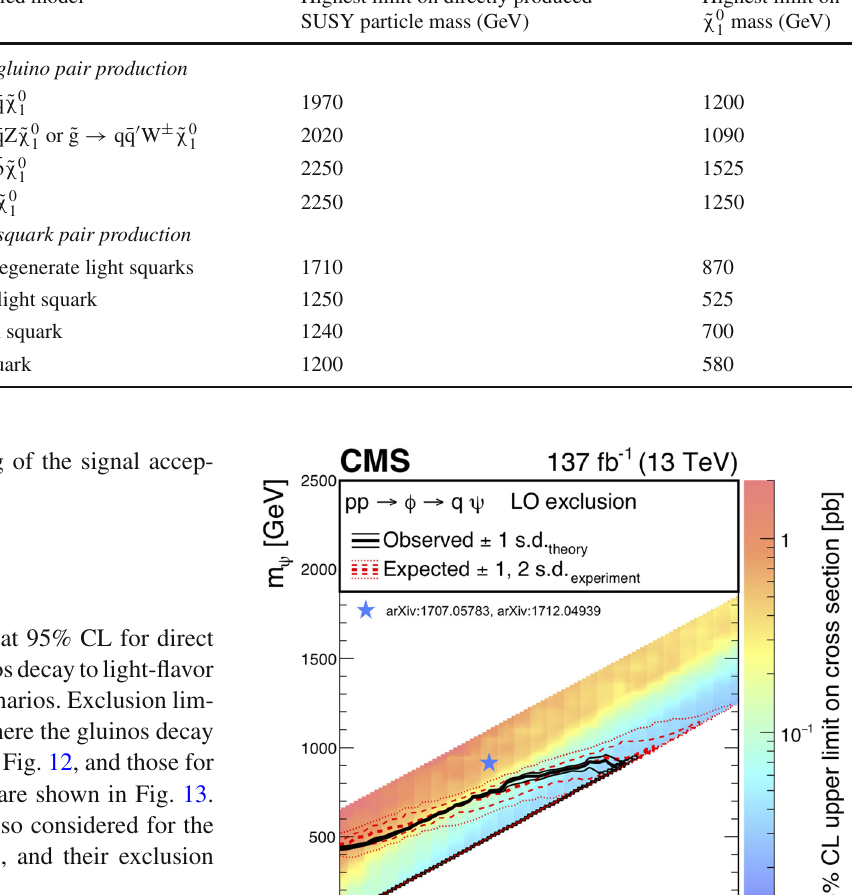
Table 8 Summary of the Simplified model Highest limit on directly produced observed 95% CL exclusion limits on the masses of SUSY particles for different simplified model scenarios. The highest limits on the mass of the directly produced particles and on the mass of the ˜ χ 0 are quoted 1